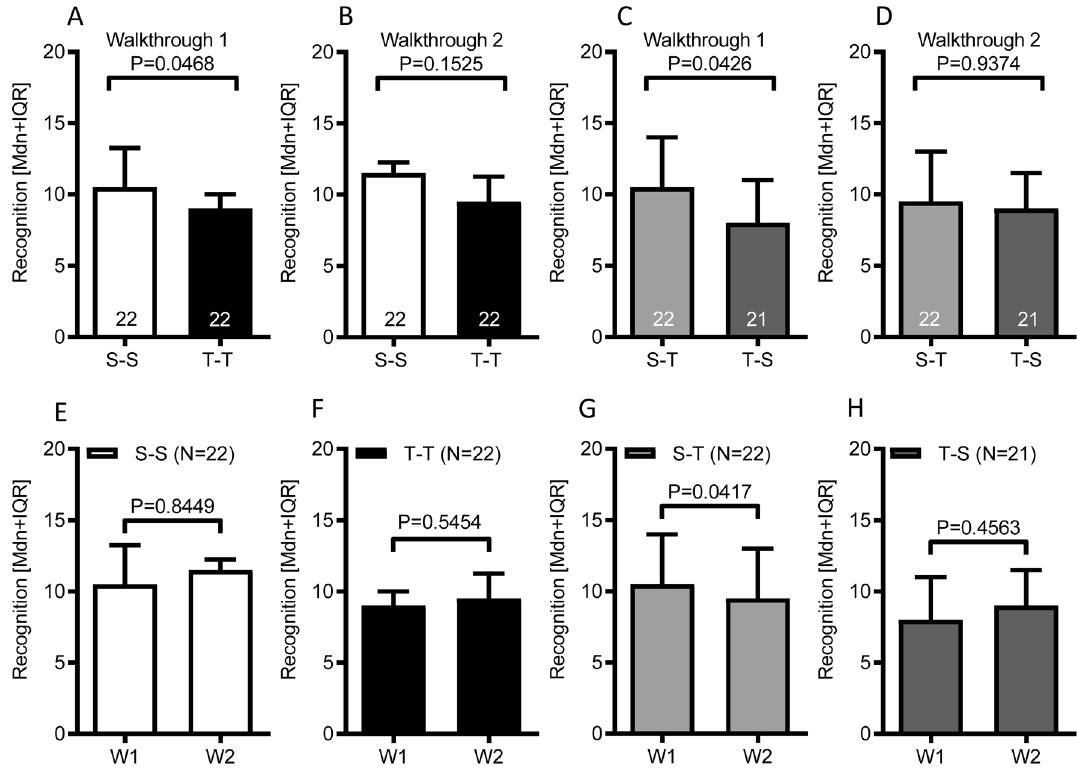
Figure 3. Recognition memory performance for information encoded either under threat or safety conditions. ( A, B ) Recognition memory performance for information encoded during the passive walkthrough 1 or 2 by the Safety-Safety and Threat-Threat experimental groups. Bars represents the median and interquartile range [Mdn + IQR] of total recognition scores. Numbers within the bars indicate the sample size of the experimental condition. P -values given refer to Mann–Whitney U test for independent samples. Abbreviations: S-S: Safety- Safety condition; T-T: Threat-Threat condition. ( C, D ) Recognition memory performance for information encoded during the passive walkthrough 1 or 2 by the Safety-Threat and Threat-Safety experimental groups. Bars represents the median and interquartile range [Mdn + IQR] of total recognition scores. Numbers within the bars indicate the sample size of the experimental condition. P -values given refer to Mann–Whitney U test for independent samples. Abbreviations: S-T: Safety-Threat condition; T-S: Threat-Safety condition. ( E–H ) Within- group dynamics of recognition memory performance for information encoded during the passive walkthrough 1 or 2. Bars represent the median and interquartile range [Mdn + IQR] of corresponding visual analog scale ratings. P-values given refer to Wilcoxon signed rank tests for dependent samples. Abbreviations: S-S: Safety- Safety condition; T-T: Threat-Threat condition; S-T: Safety-Threat condition; T-S: Threat-Safety condition; W1: Passive walkthrough video 1; W2: Passive walkthrough video